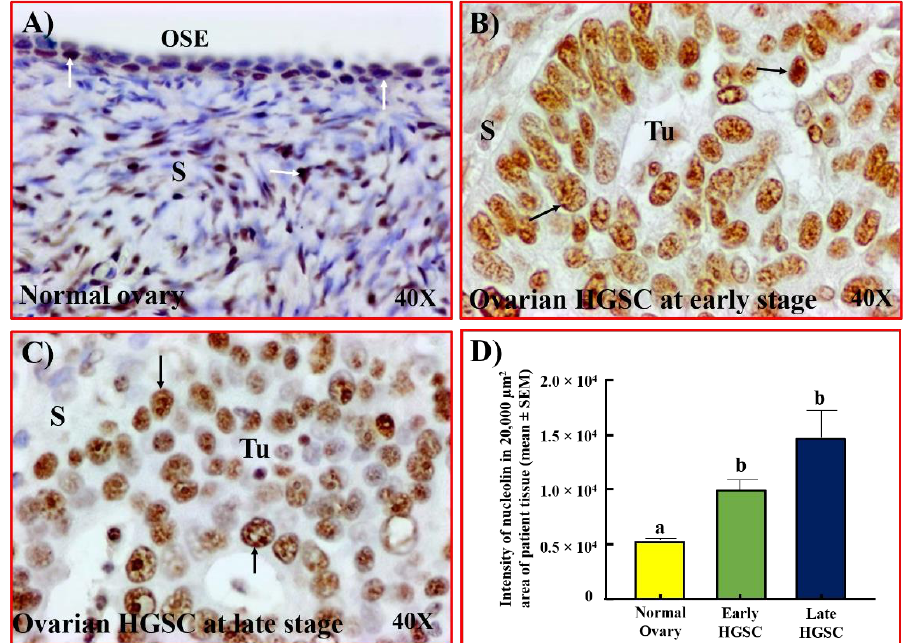
Figure 1. Localization of nucleolin in ovarian HGSC. ( A ) Section of a normal ovary showing the expression of nucleolin by a few OSE cells and stromal cells. ( B , C ) Sections of ovarian HGSC from patients with early ( B ) and late-stage ( C ) disease showing intense staining for nucleolin by malignant cells. ( D ) The intensity of the immunohistochemical staining of nucleolin was quantified and summarized as the mean ± SEM in a 20,000 µ m 2 area of tissue. Each bar represents the intensity of nucleolin expression in subjects with normal ovaries ( n = 8) or patients with early ( n = 5) and late stages ( n = 5) of ovarian HGSC. Compared with normal ovaries, the expression of nucleolin was significantly higher in ovarian HGSC at early and late stages ( p < 0.05). Bars with different letters are significantly different in their nucleolin expression (normal vs. early p < 0.05; normal vs. late p < 0.01). Arrows indicate examples of immunopositive cells. OSE = ovarian surface epithelium, S = stroma, Tu = tumor. Magnification = 40 × .